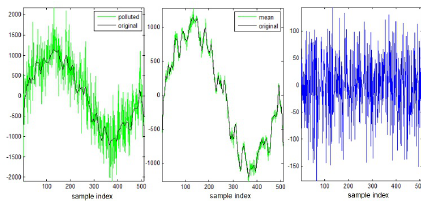
Figure 4. Signal of 50 periods. Left: 1-st pe- riod from the test signal before and after pol- lution with the most powerful noise; middle – mean signal and 1-st period from the original (non-polluted) signal; right – di ff erence between the mean signal and the 1-st period of the signal before pollution.